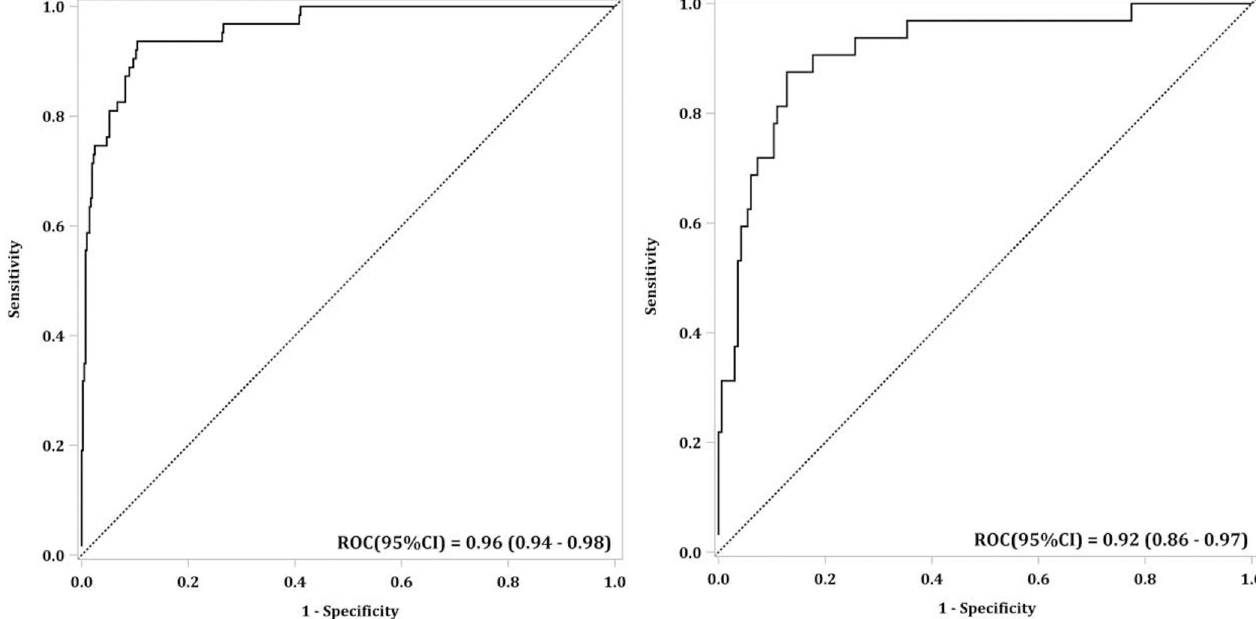
Fig 2. Receiver operating characteristic curve of the training (left) and validation (right) dataset. ROC–Receiver operating characteristic. CI–Confidence